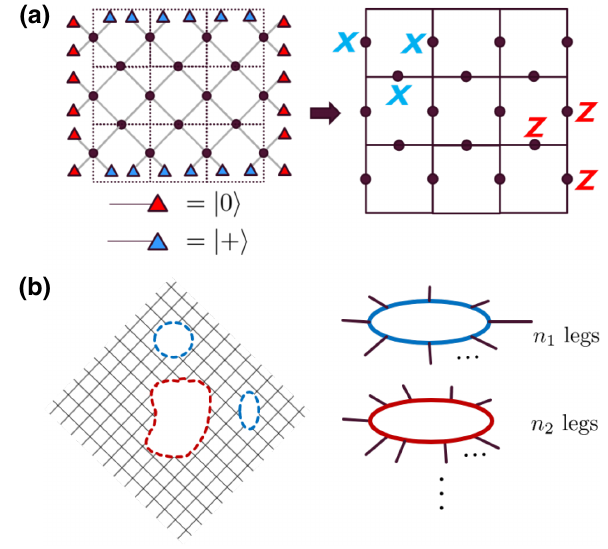
FIG. 8. (a) By contracting the dangling legs of a patch of the tensor network with the X and Z eigenstates, one can confirm using operator pushing that we recreate the 2D surface code with the correct number of qubits and the different boundary con- ditions. The gray solid lines represent the contracted in-plane edges. For each site or tensor marked by a black dot, there are also two dangling legs pointing into and out of the page. These legs are not shown to avoid clutter. (b) One can string together different repetition codes in a tensor network (as denoted by the different colors) and connect some of them to the dangling legs of the 2D tensor network with holes. Each colored boundary rep- resents contraction with a boundary tensor of the same color on the right.